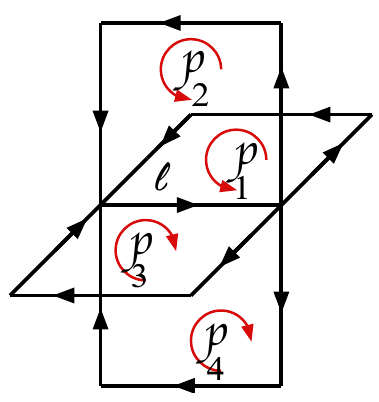
Figure 2 . Coboundary operator on a link in a 3d lattice: δ‘ = p 1 + p 2 + p 3 + p 4